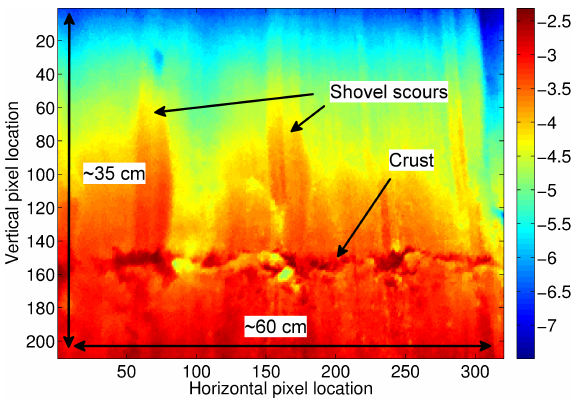
Fig. 4. Horizontal temperature profiles at the first and last time step Fig. 5. Thermal image of the specimen shown in Fig. 1b after ap- at vertical pixel location 100 (see Fig. 2). Areas with a slower cool- proximately 4 min in the cold lab. Artificial concavities are rela- ing process are marked in red circles which correspond to the shovel tively warm, convexities are relatively cold. The marked area is fur- ther analysed in Fig. 6. Colorbar in ◦ C.